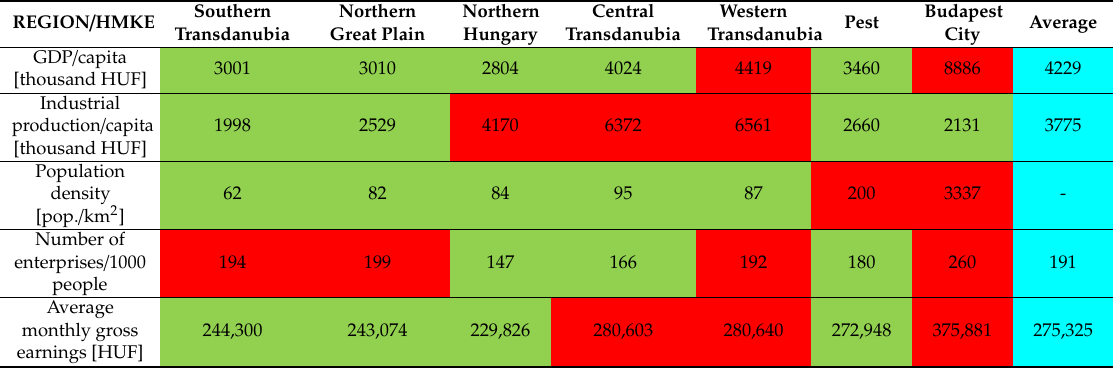
Table 6. Economic and demographic indicators in the seven examined regions of Hungary (red: above the average, green: under the average, blue: average).